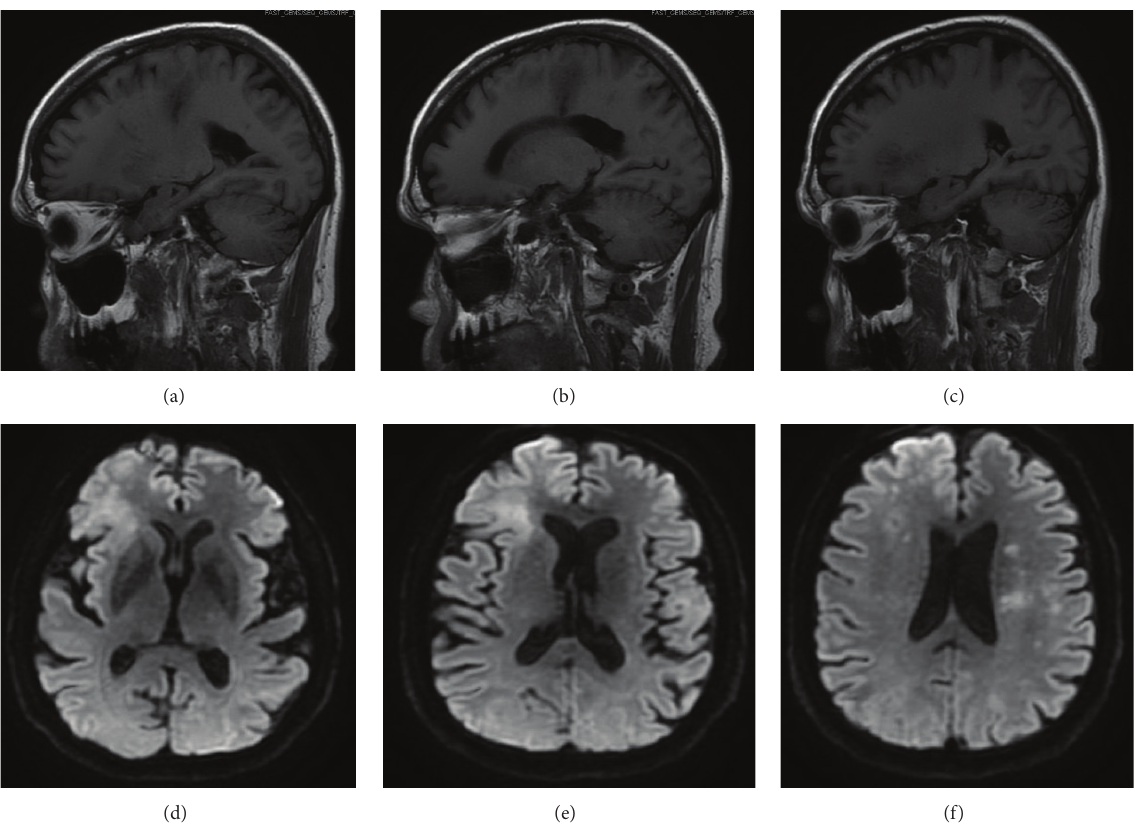
Figure 3: T1-weighted sagittal images (a–c) and diffusion-weighted images (DWI) (d–f). Images progress from right to left from (a) through (c). Images progress superiorly to inferiorly from (d) through (f).